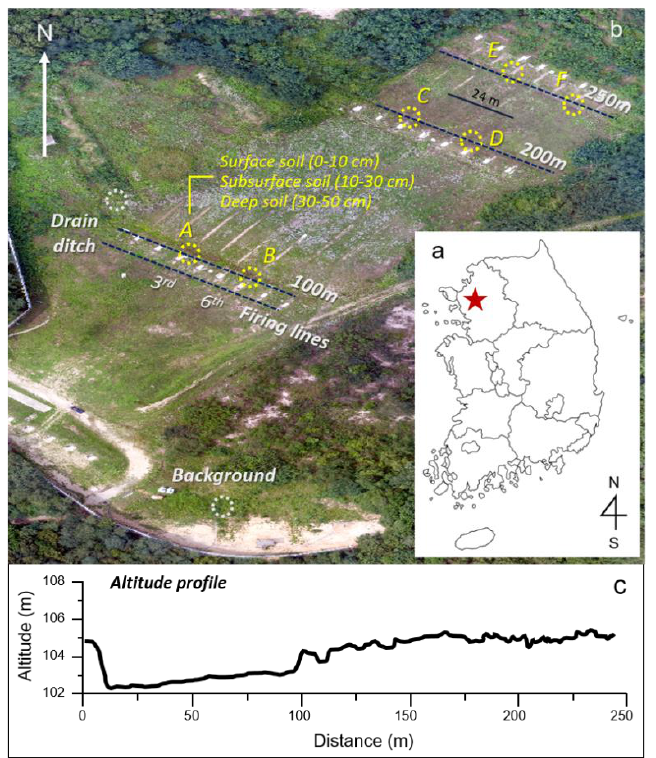
Figure 1. ( a ) Geological map of the Korean military shooting range in South Korea. ( b ) Specific soil sampling locations in the third (A, C, E) and sixth (B, D, F) shooting lanes. ( c ) Altitude profile of studied shooting range [22].